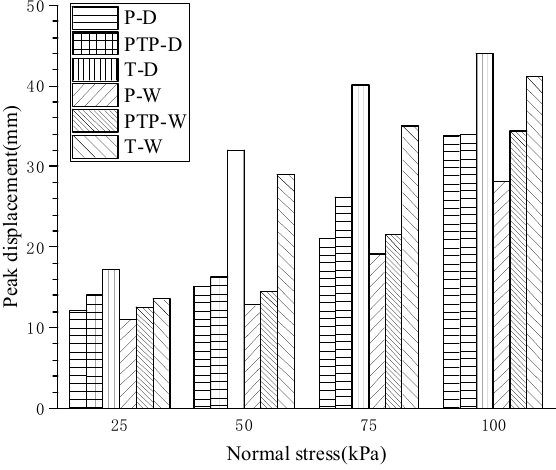
Figure 7. Relationship between peak displacement and normal stress for di ff erent interfaces. Before reaching the peak pulling force, the displacement of pulled woven fabric decreased from the clamping end to the free end, and the displacement mainly manifested as tensile deformation of the woven fabric. When the pulling force reached its peak, the displacement was transmitted to the free end, and the entire pulled woven fabric began to slide. Therefore, there were two displacement components: tensile deformation of pulled woven fabric (before peak displacement) and overall sliding displacement (after peak displacement). As can be seen from Figure 5, the shear characteristics in the same interface were di ff erent in the stage of tensile deformation and the stage of overall sliding. In the stage of tensile deformation, shear stress increased with an increase of tensile deformation. In overall sliding stage, the interface experienced varying degrees of softening which was positively correlated with normal stress acting on